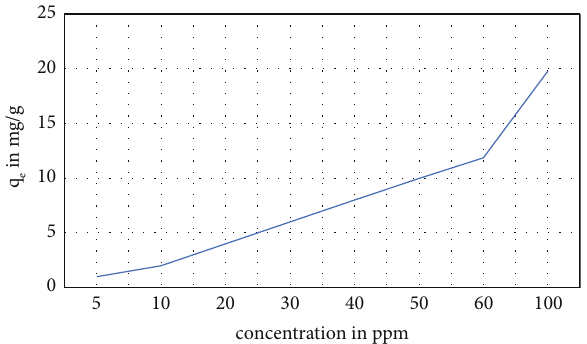
Figure 17: Effect of concentration on adsorption of